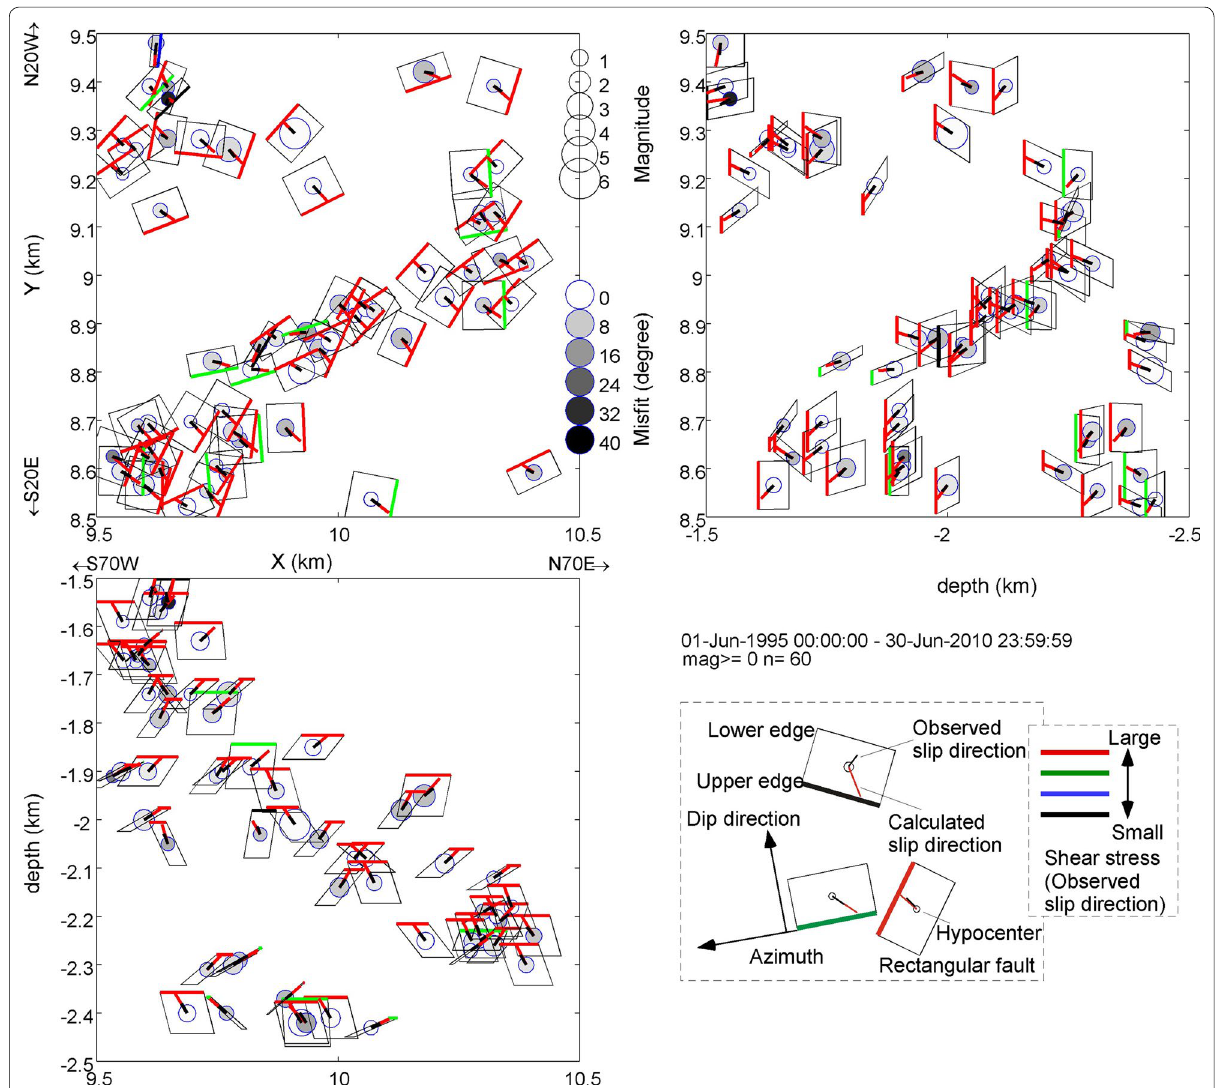
Fig. 9 Results of stress inversion for a grid point ( x 10, y 9, z 2) away from the mainshock fault. Rectangles are estimated fault planes = = = − projected onto the horizontal and two vertical sections. The upper edges of fault planes are indicated by thick colored edges, which represent the normalized shear stress on the fault plane based on color. Black, blue, green, and red indicate normalized shear stress of 0–0.2, 0.2–0.3, 0.3–0.4, and 0.4–0.5, respectively. Observed and calculated slip directions are shown by black (short) and red (long) bars at the center of the rectangle, respec- tively. Diameters and colors of circles represent magnitudes and misfits (difference between observed and calculated slip directions),